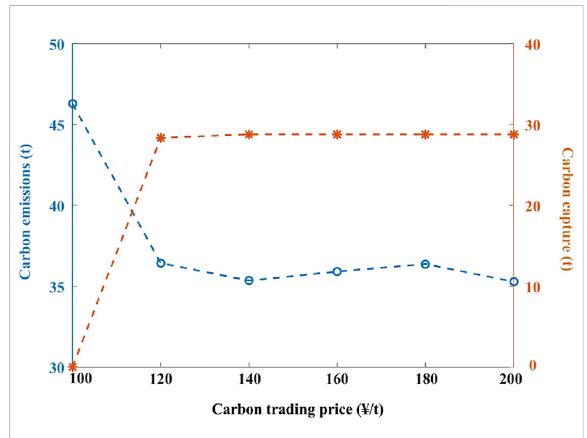
FIGURE 8 Relation curve between carbon emissions, carbon capture and carbon trading